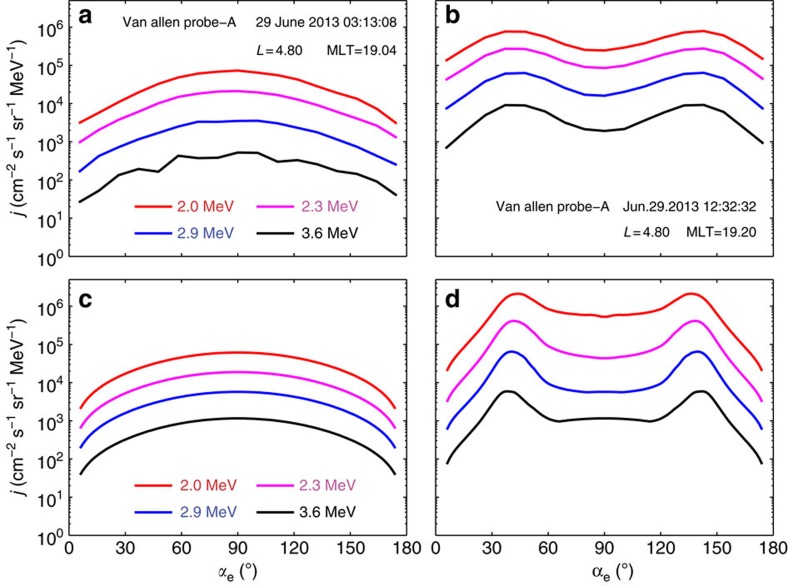
Comparison of Fokker–Planck simulation results with observations.(a,b) Observed evolution of the relativistic electron fluxes as a function of pitch angle at the same location (shown inside panels) during the simulation. (c,d) Starting with an initial condition representative of relativistic electrons (a), we show the relativistic (2–3.6 MeV) electron fluxes due to acceleration by chorus and MS waves from a numerical solution to the two-dimensional Fokker–Planck diffusion equation. Acceleration is most pronounced within the medium pitch angle region 30°–60° or 120°–150° produced by both chorus and MS waves, and noticeable around the high pitch angles induced by chorus waves. The combined acceleration by chorus and MS waves leads to the butterfly distribution both in the magnitude and the time scale (d) comparable to the observation (b). The current simulation provides a further support for wave-driven butterfly distribution of relativistic electrons during this storm.